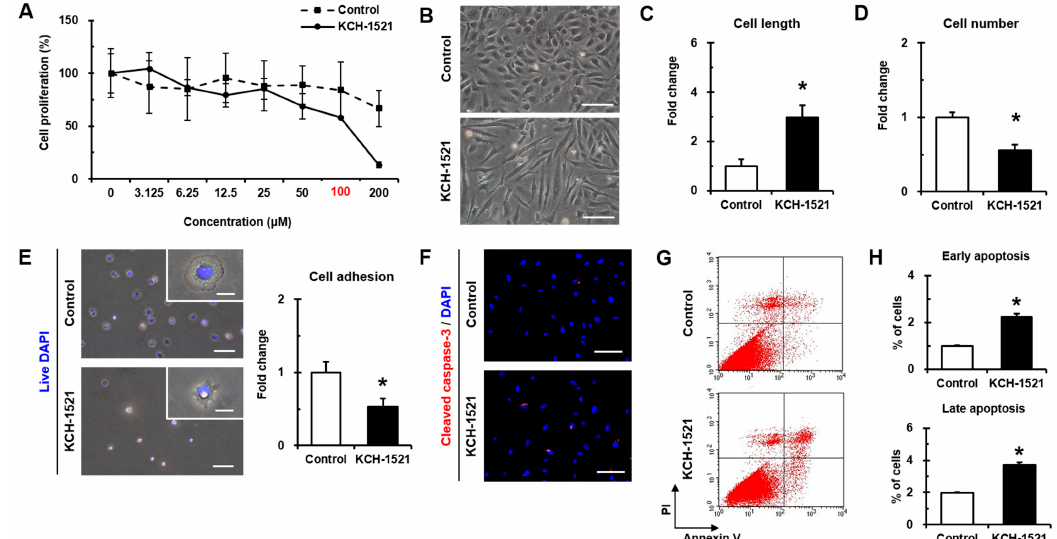
Figure 2. Characterization of the effects of KCH-1521 on human umbilical vein endothelial cells (HUVECs). ( A ) WST-1 assay indicating dose-dependent cell proliferation of HUVECs. The untreated condition (0 μ M) was regarded as a 100% cell proliferation rate. The experimental concentration of KCH-1521 was 100 μ M (red); ( B ) representative phase-contrast images of HUVECs after 24 h of treatment with KCH-1521 at a concentration of 100 μ M. Scale bars = 100 μ m; ( C ) cell length of single cells measured in terms of long axis; ( D ) Cell number quantified after 24 h of treatment; ( E ) representative overlapped immunofluorescence and phase-contrast images after 10 min of attachment, and quantification of attached cells. Nuclei were stained with live DAPI (4 ′ ,6-diamidino-2-phenylindole; blue). Scale bars = 100 μ m for the large panels, and 20 μ m for the magnified insets; ( F ) Representative immunofluorescence images showing cleaved caspase-3 (red) expression in the control and KCH-1521-treated cells. Nuclei were stained with DAPI (blue). Scale bars = 100 μ m; ( G ) flow cytometric analyses of Annexin V and propidium iodide (PI) staining in the control and KCH-1521-treated cells; ( H ) quantification of early (Annexin V-positive and PI-negative) and late (Annexin V-positive and PI-positive) apoptotic cell ratio. Data shown represent the mean ± SD of three independent experiments (* p < 0.05).